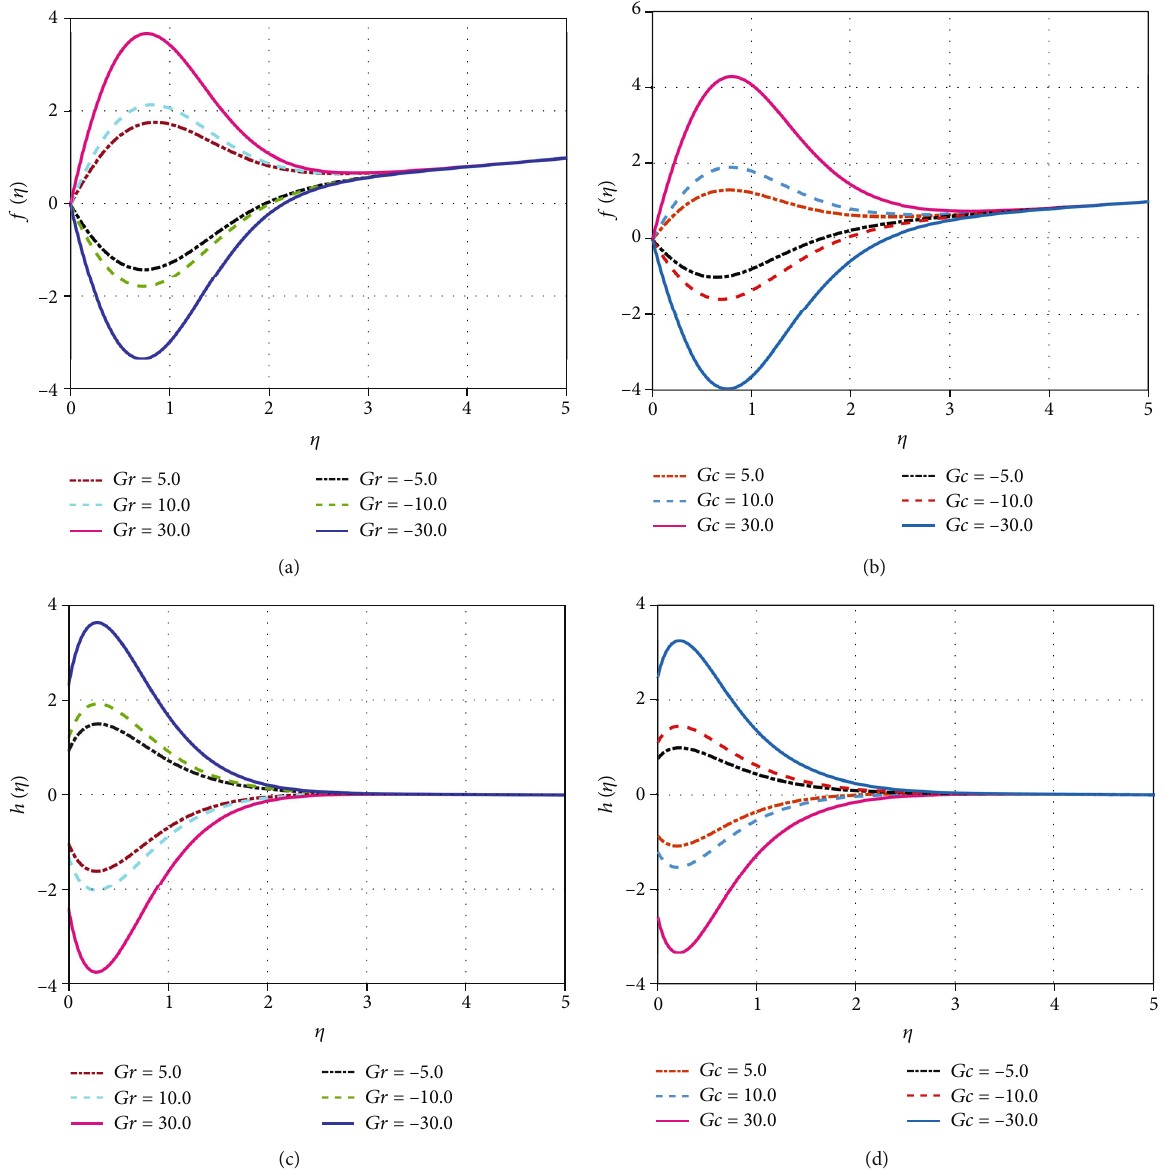
Figure 4: Velocity pro fi les for the variation of (a) thermal Grashof number, (b) solutal Grashof number and micro-rotation pro fi les for the variation of (c) thermal Grashof number, (d) solutal Grashof number with constant values of γ = 45 ° , M =2, c =0.5, R =0.5, Pr =0.71, =0.33, λ = 1, ξ =3, K =0.5, Gc Sc =0.22, L 1 1